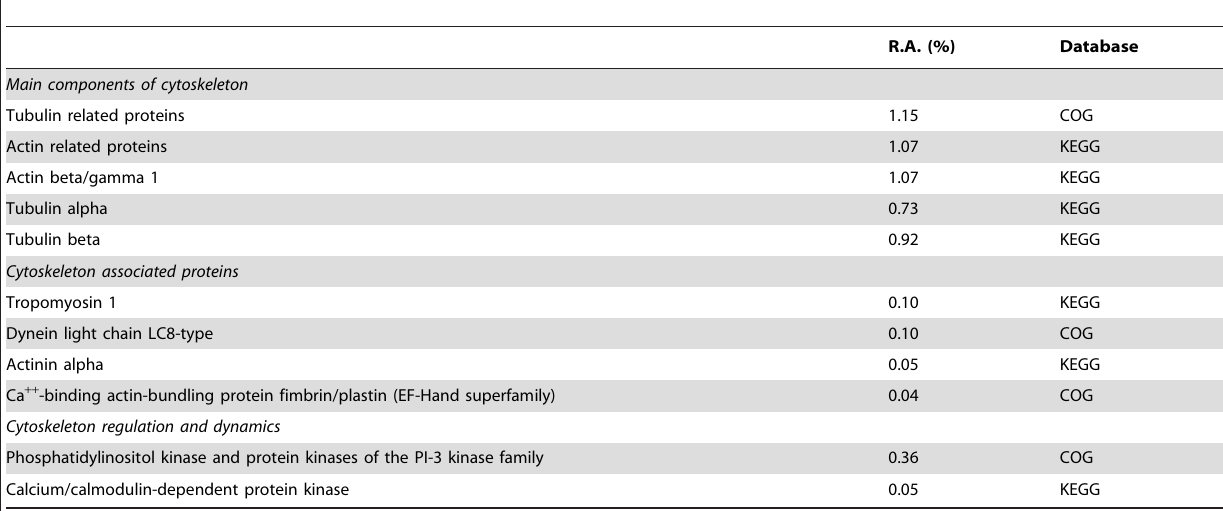
Table 2. Main transcripts related to cytoskeleton in L. dendroidea .